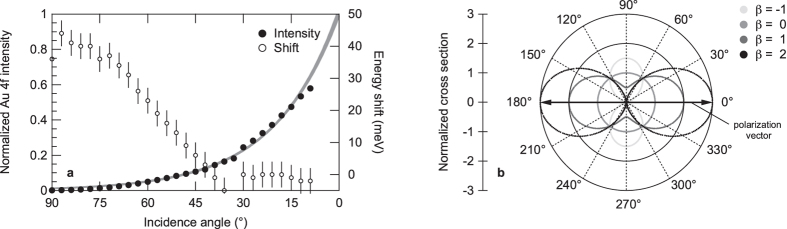
Photoelectron spectroscopy at grazing photon incidence.(a) Normalized photoemission signal of the Au 4f core-level spectra measured at BL17SU of SPring-8 (hν = 600 eV; β = 0.707523) and corresponding space charge-induced spectral shift as a function of incidence angle. The solid gray line is a phenomenological fit to the experimental data. (b) Angular distribution of photoelectrons from free atoms. For a positive asymmetry parameter β, the photoemission intensities have a maximum at the direction of the polarization vector, i.e., when measuring in a grazing incidence and normal emission geometry2223.